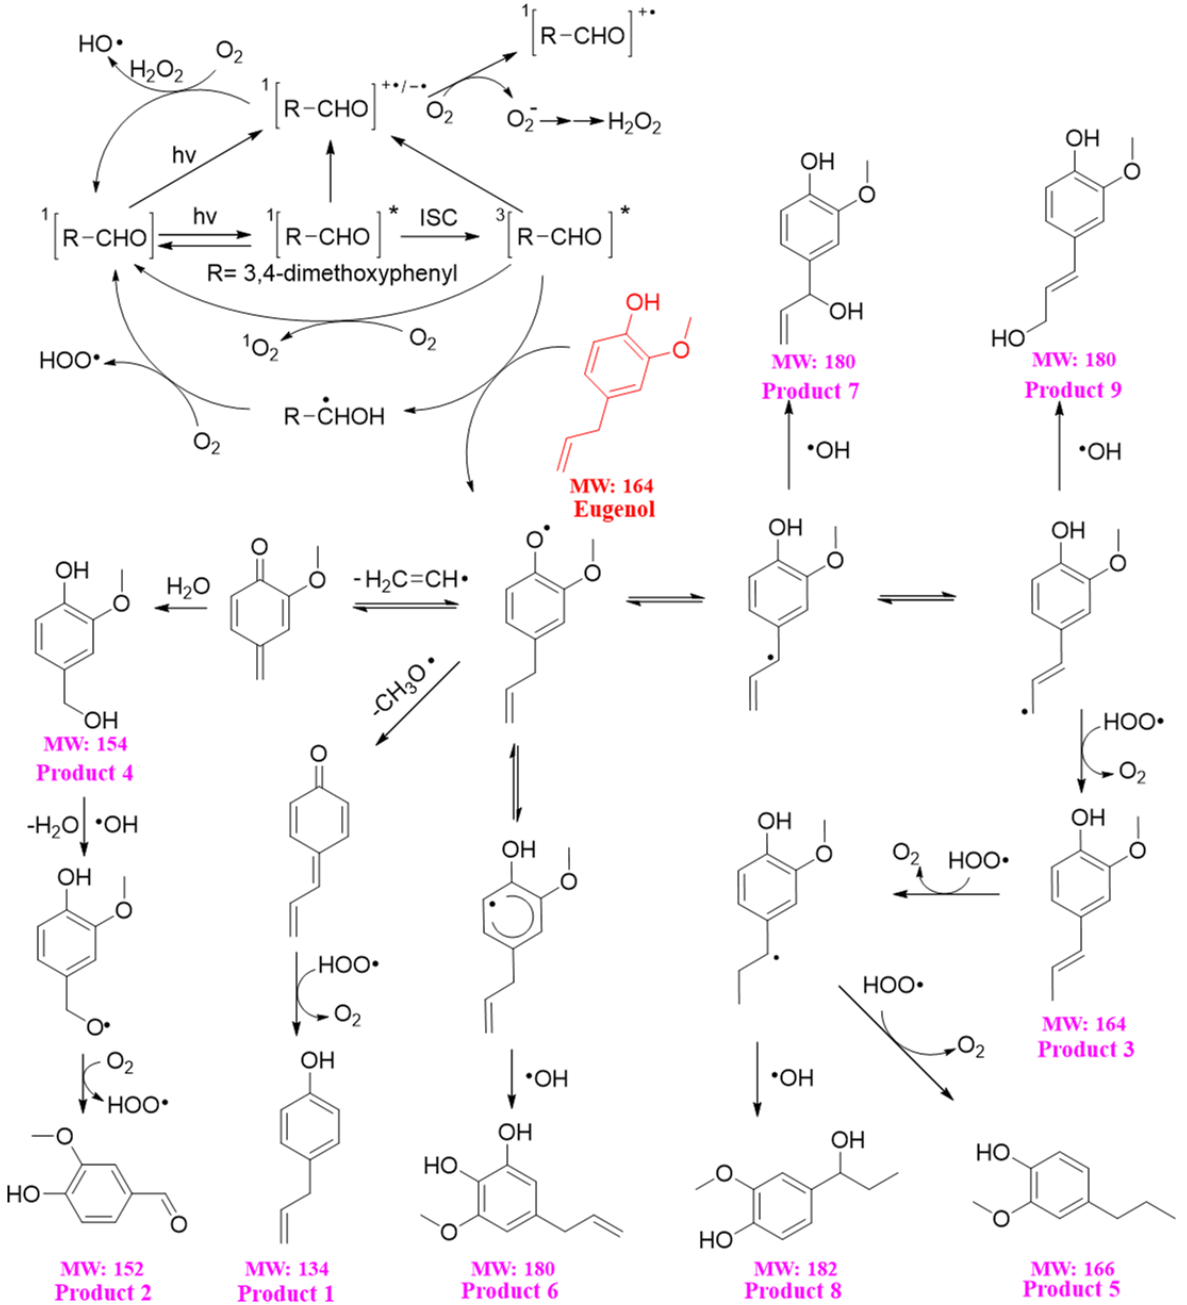
Figure 10. Proposed reaction mechanism of 3 C ∗ -initiated photooxidation of eugenol. The red text represents the precursor, and the com- pounds labelled as products 1–9 are those identified by GC-MS (Table